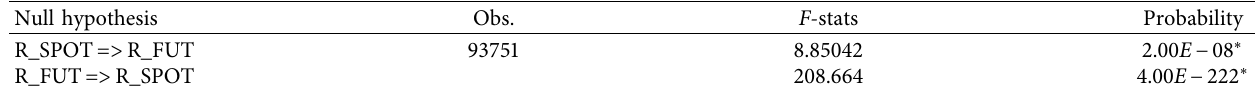
Table 4: Granger causality